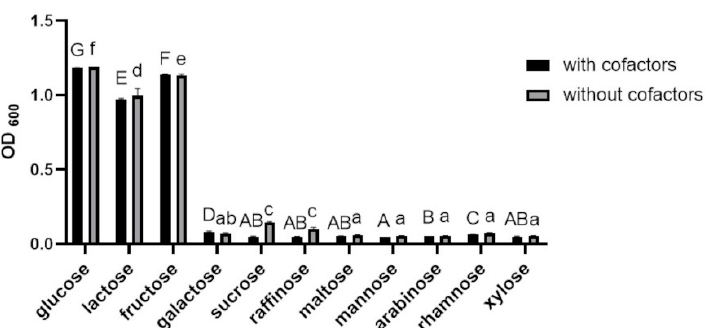
Figure 2. Growth of B. bifidum BGN4-SK in MRS medium containing 2% ( w/v ) of different carbon sources with/without cofactors (500 µ M MnSO 4 and 30 µ M hematin). Data represent means ± standard deviations, n = 3. Bars with different letters indicate significant differences ( p < 0.05; one-way ANOVA with Duncan’s multiple range test). No significant differences between the samples with and without cofactors ( p > 0.05; Student t -test).